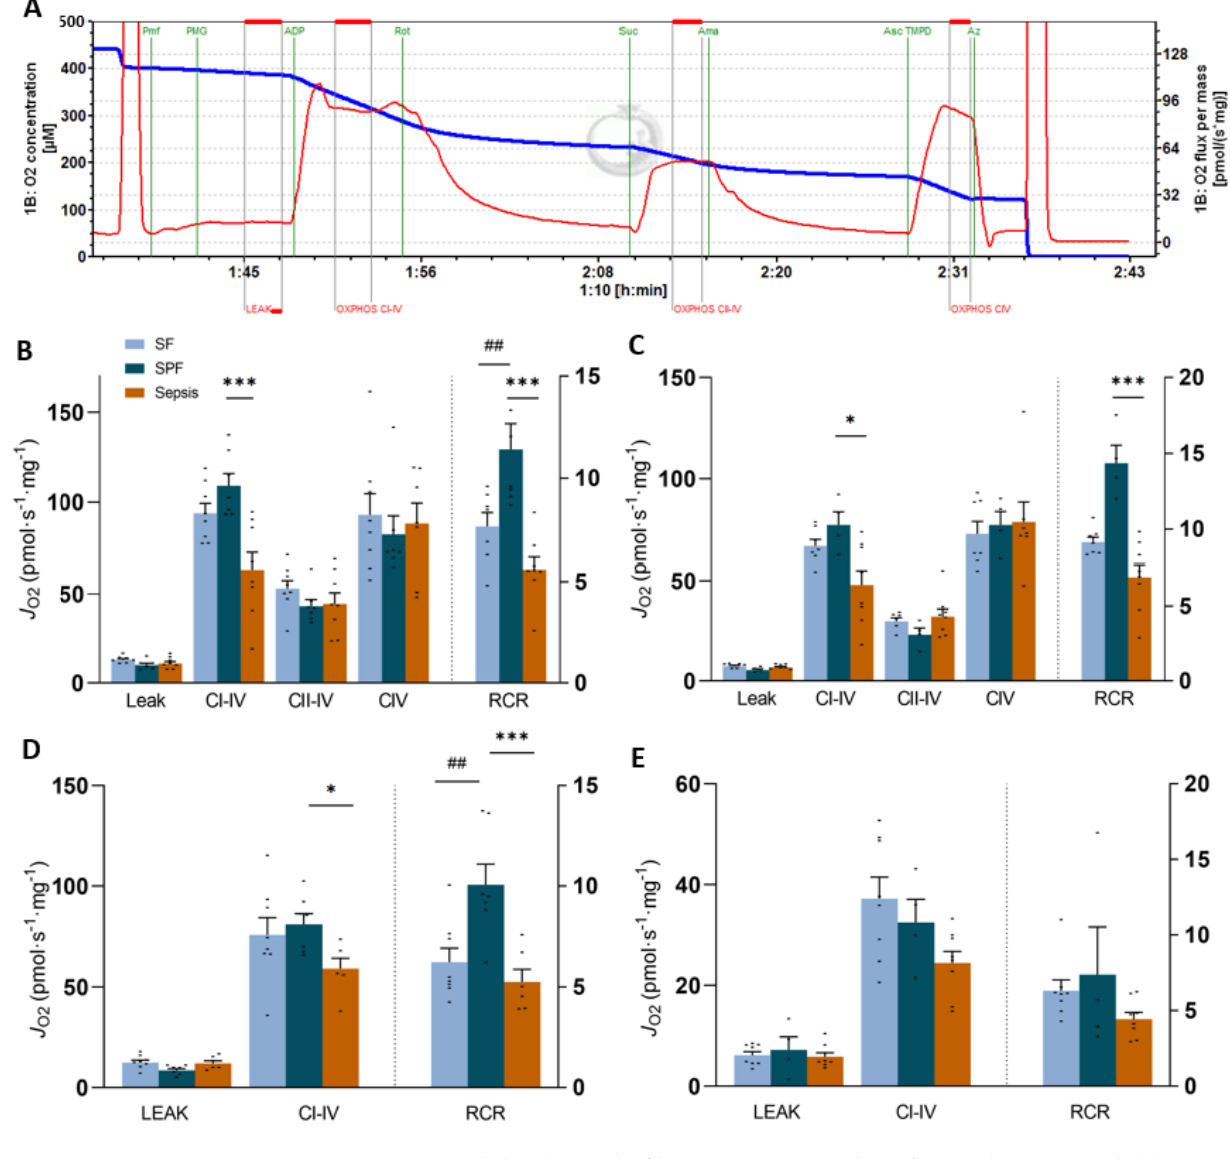
Figure 4. Permeabilized muscle fiber respiration in the soleus and EDL. Panel ( A ) represents PMG-linked JO 2 curve after incubating permeabilized muscle fiber (pmf) from soleus of a Sham-fed (SF) mouse. See Figure S4 for other representative curves and more details. Panels ( B , C ) represent soleus ( B ) and EDL ( C ) pmf oxygen consumption (JO 2 ) recorded after sequential injections: pyruvate (5 mM), malate (2 mM), and glutamate (10 mM) (PMG) (LEAK); ADP (5 mM) (CI–IV for oxidative phosphorylation (OXPHOS) state driven by complex I); rotenone (Rot, 0.5 µM) and succinate (Suc, 10 mM) (CII–IV for OXPHOS state driven by complex II); antimycin A (Ama, 2.5 µM), ascorbate (Asc, 2 mM) and TMPD (0.5 mM) (CIV for OXPHOS state driven by CIV). Panels ( D , E ) represent soleus ( D ) and EDL ( E ) pmf JO 2 recorded after sequential injections: octanoyl-carnitine (0.5 mM) and malate (2 mM) (LEAK), and then ADP (5 mM) (CI–IV). The respiratory control ratio (RCR) is plotted on the right Y -axis in each graph. One value excluded due to cytochrome c elevation in B–D. Light- blue bars for the SF group (n = 7), dark-blue bars for the SPF group (n = 4–7), and orange bars for the Sepsis group (n = 7–8). Data are expressed as mean values with SEM and analyzed by one-way ANOVA with post hoc Fisher’s LSD test ( A , C ) or a Kruskal–Wallis test with a post hoc Dunn’s test ( B , D ). # SPF vs. SF and * Sepsis vs. SPF. * p < 0.05, ## p < 0.01, *** p <